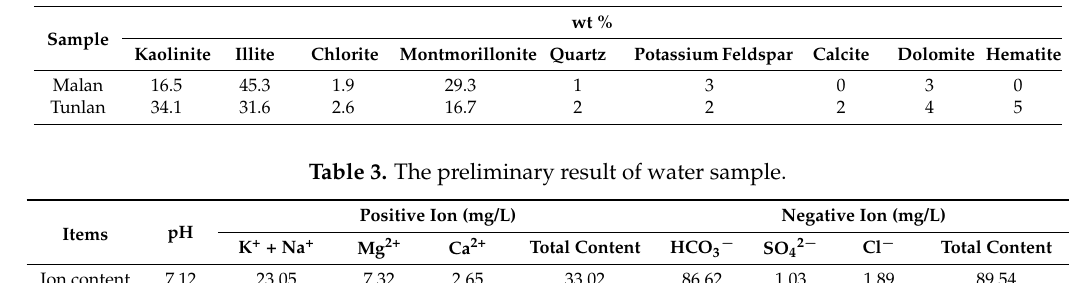
Table 2. Mineral composition of coal samples.